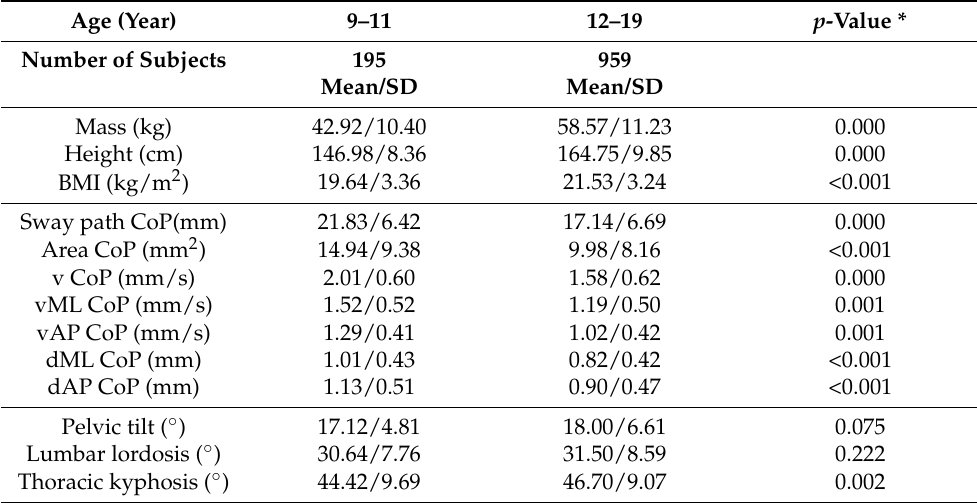
Table 2. Sample characterization, stabilometric and angular variables, separated by groups: children and adolescents.